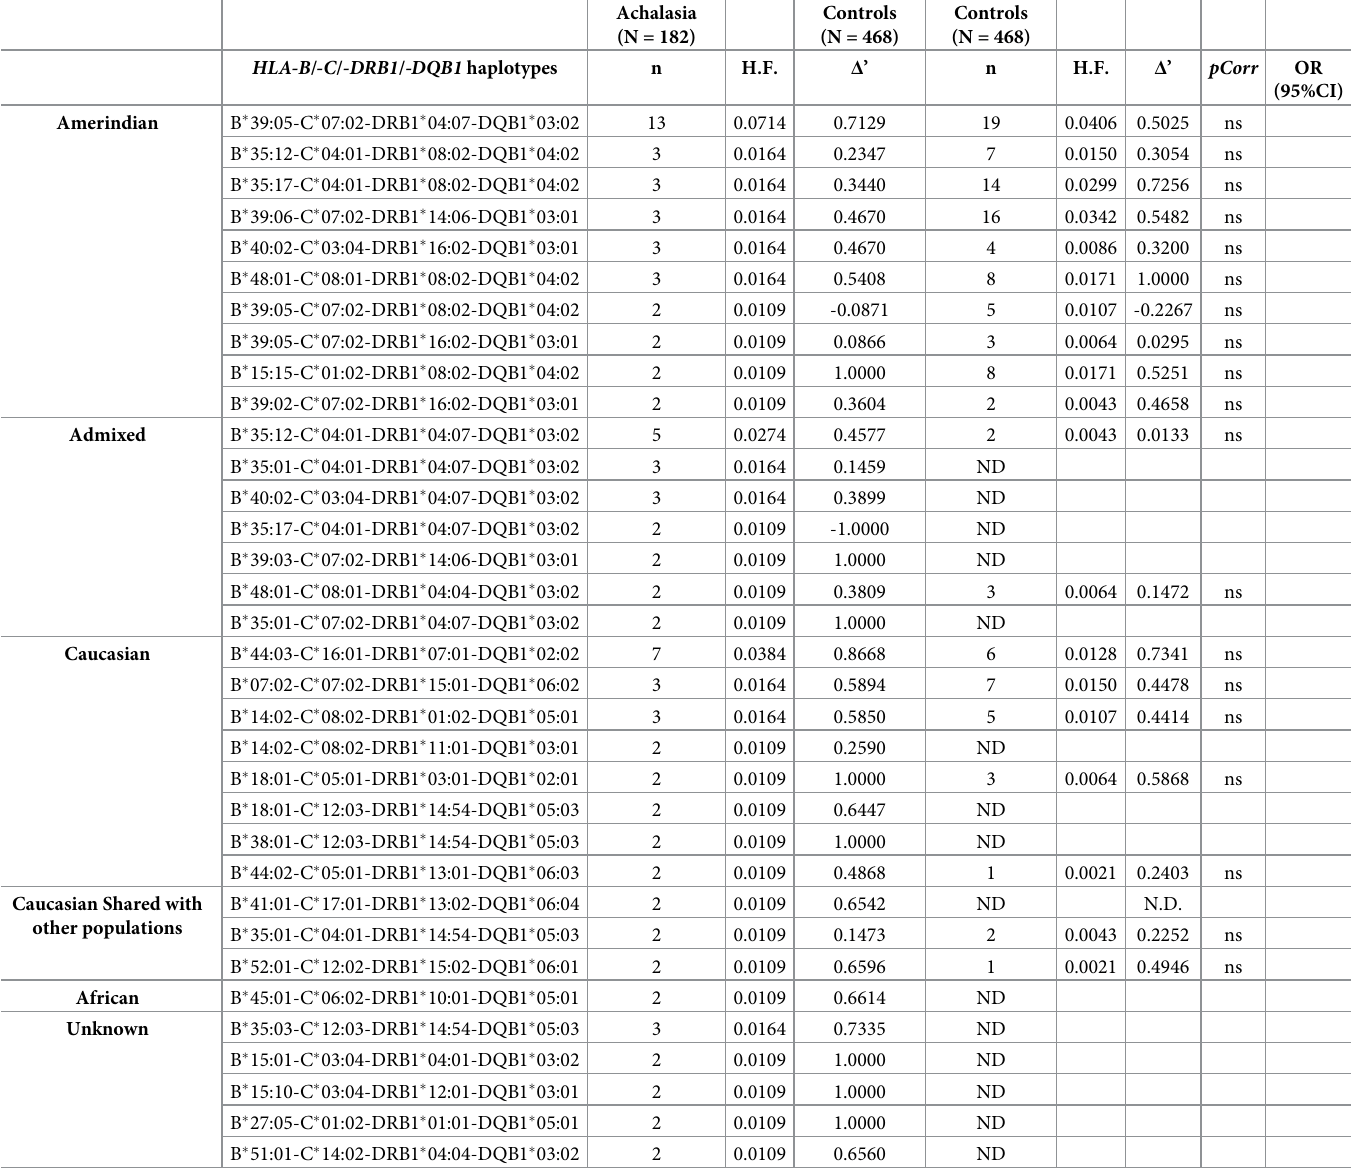
Table 6. HLA-B/-C/-DRB1/-DQB1 conserved extended haplotypes in achalasia patients and healthy controls.